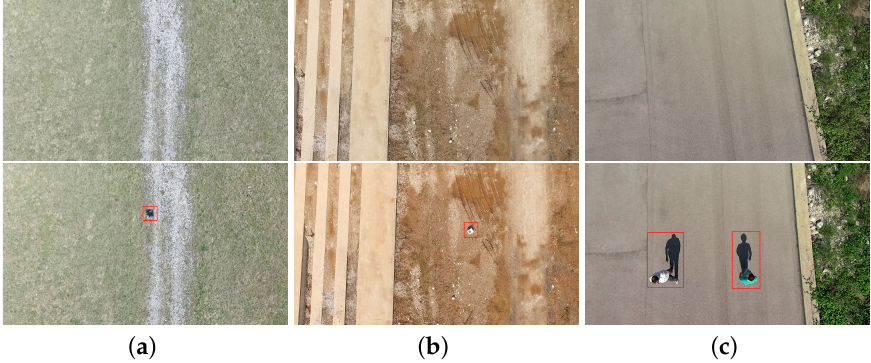
Figure 5. In ( a – c ), image samples for different paths in the UMCD dataset. In the top row, frames associated to the normal scene. In the bottom row, the same frames depicting abnormal elements highlighted in the red bounding